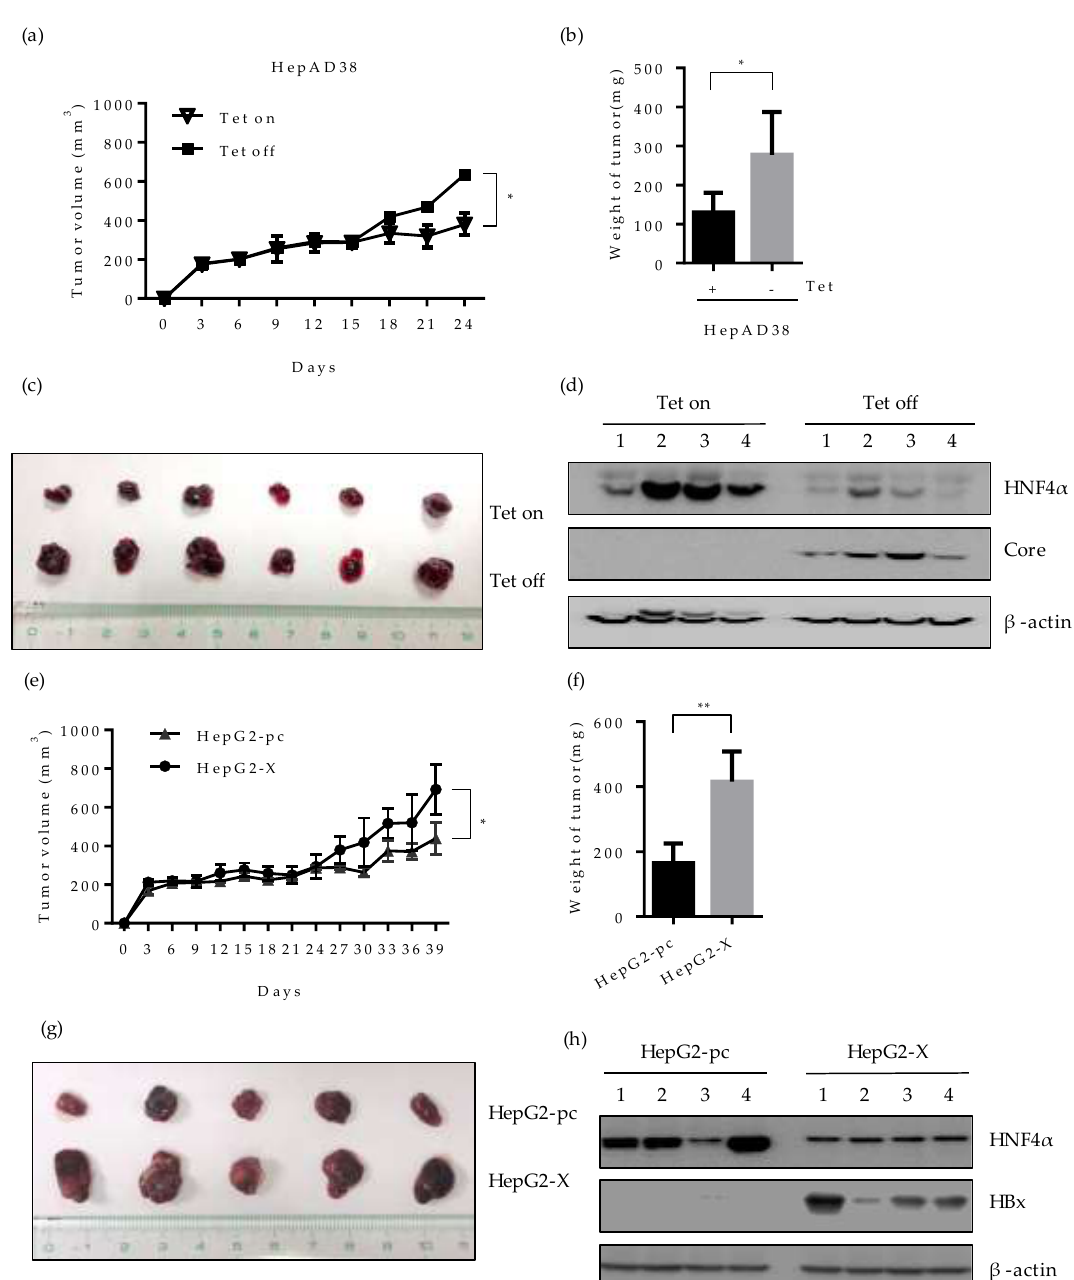
Figure 7. Effect of HBV-induced HNF4α suppression on tumor formation and growth in a xenograft mouse model. HepAD38 ( a – d ) or HepG2-X (e-h) cells (1 × 10 7 ) were mixed with Matrigel (1:1) and injected subcutaneously (SC) into the nude mice (n=5-6/group). ( a,e ) The size of tumors bearing the indicated cells was measured every three days. The volume of the tumor was calculated and is shown in the growth curve. The Tet-on mice were housed with water containing 2 mg/mL tetracycline. Mice were sacrificed after 4 weeks. ( b,f ) Tumor weight after 4 weeks of injection were plotted. * p < 0.05. (c,g) Pictures of xenografted tumors at 4 weeks following SC injection. ( d,h ) The expression levels of HNF4α and HBV core/HBx protein in representative mouse livers were determined by Western blotting at 4 weeks post SC injection.